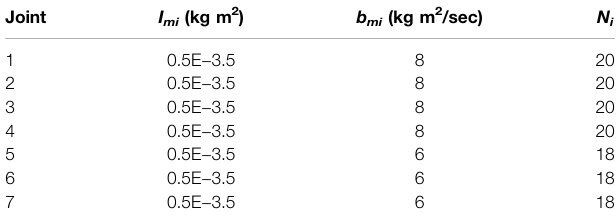
TABLE 1 | Assumed Baxter robot parameters.